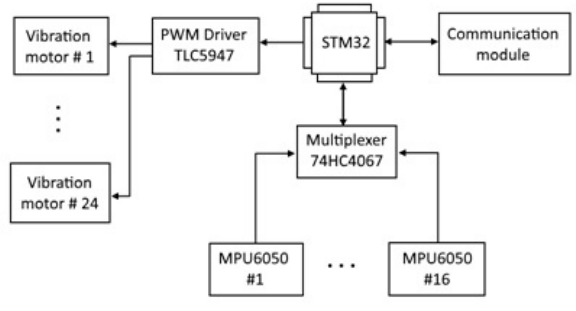
Figure 3: Control system diagram.